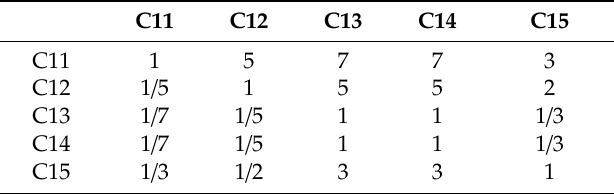
Table 4. Pairwise comparisons of indicators